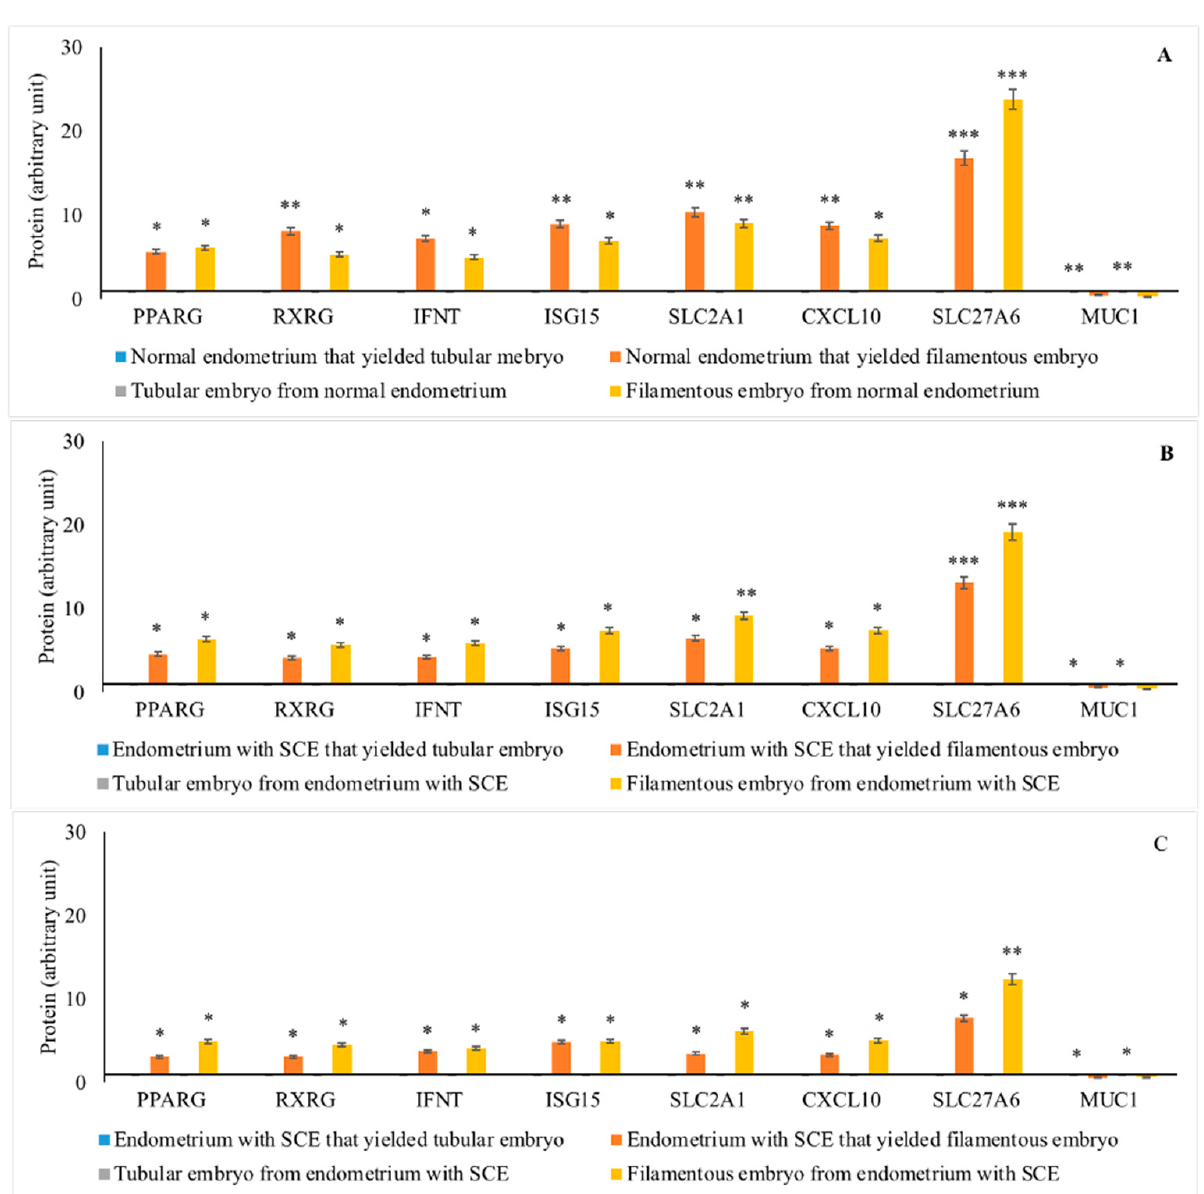
Figure 4. Protein abundances (mean ± SEM) in gestational day (GD) 16 filamentous conceptus 1 and corresponding endometrium (compared to tubular conceptus 1 and corresponding endometrium §) from repeat breeder 2 cows with or without subclinical endometritis 3 following transfer of GD 7 embryo Quality Grade 4 (QG) 1 ( A ), embryo Grade 2 ( B ) and embryo Grade 3 ( C ). § Reference group, relative mRNA expression is equal to 1 fold; * p < 0.05; ** p < 0.01; *** p < 0.001; 1 Filamentous conceptus, ≥ 25 mm long; Tubular conceptus, 10 to 20 mm long; 2 repeat breeder cows were with the history of failing to conceive after the first three inseminations post calving and with the history of at least one pregnancy loss between 30 and 60 days after any of the first three services during the second or third lactation; 3 Cows without subclinical endometritis, ≤ 6% PMN on endometrial cytology; 4 Embryo QG: Codes 1 to 4; 1, excellent/good; 2, fair; 3, poor; 4, unfertilized/dead/degenerate; PPAR—peroxisome proliferator-activated receptor; RXR—retinoid X receptors; IFNT—interferon- τ ; ISG15—interferon-stimulated gene-15; SLC2A1—Solute Carrier Family 2 Member 1; SLC27A6—Solute Carrier Family 27 Member 6; CXCL10—C-X-C Motif Chemokine Ligand 10; MUC1—Mucin